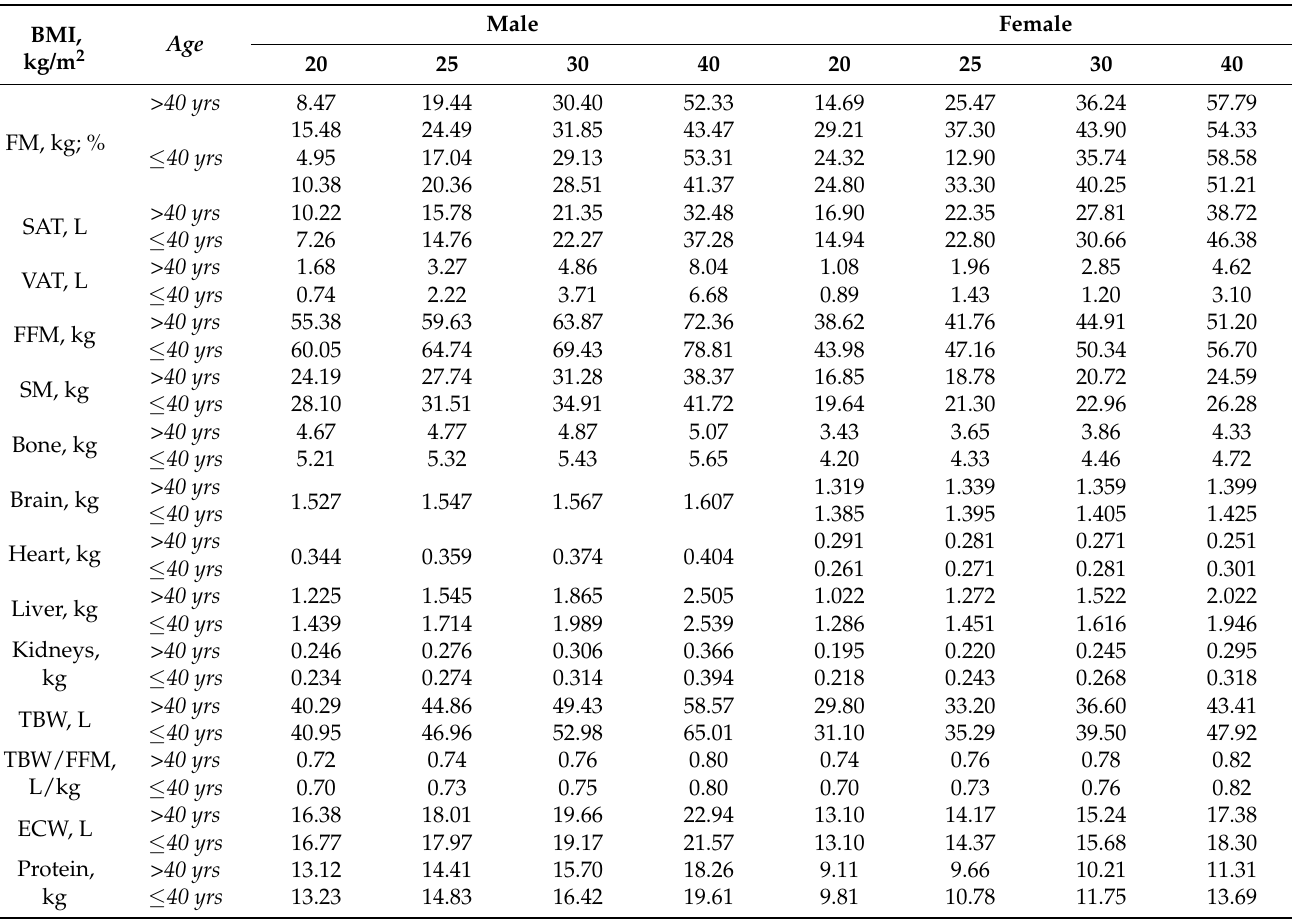
Table 1. Detailed body composition at the anatomical and molecular level of the 2021 Reference Body for males and females according to BMI categories and age of <40 yrs and >40 yrs. Since there were no significant associations between BMI and the masses of brain and heart within the individual age groups in males, the respective reference values are provided for the entire population. See Methods or details of the ‘Kiel study